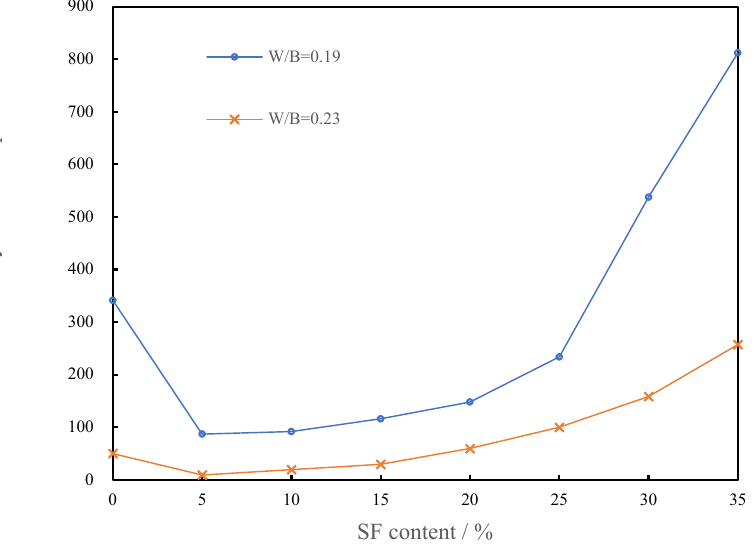
Figure 9. Effect of silica fume content on hysteresis loop area of CSHWM.